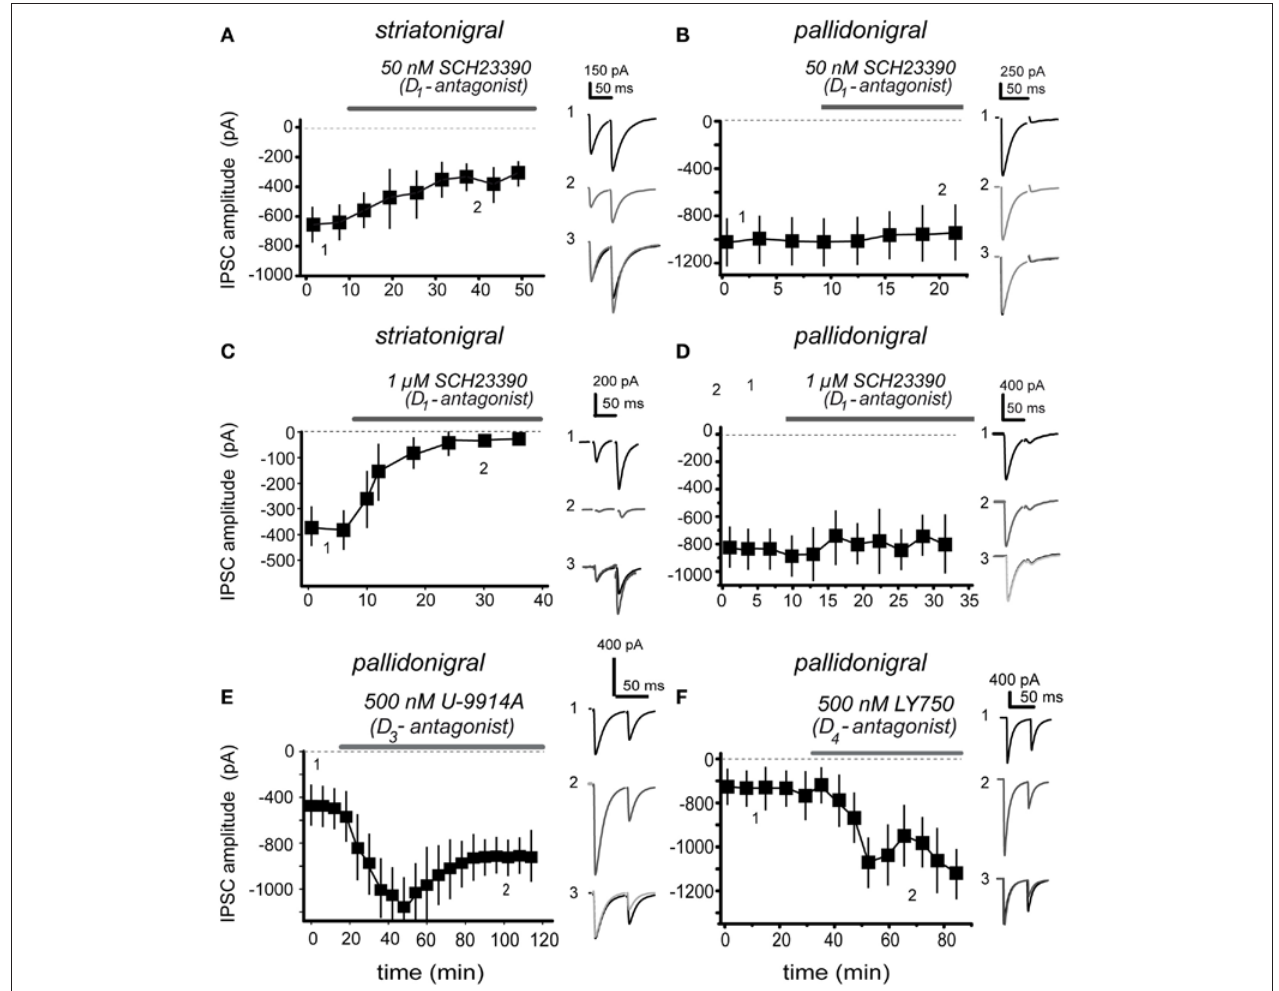
Figure 4 | Presynaptic dopamine receptors sense endogenous extracellular dopamine. (A) 50 nM of selective dopamine D antagonist, SCH 3390, are enough to reduce striatonigral IPSC amplitude. (B) The same antagonist concentration has no action on pallidonigral IPSC. (C) Increasing D -antagonist concentration (1 μM) greatly reduced IPSC 1 while speeding up dopamine actions on striatonigral IPSC, suggesting a concentration dependent mechanism. (D) The same antagonist